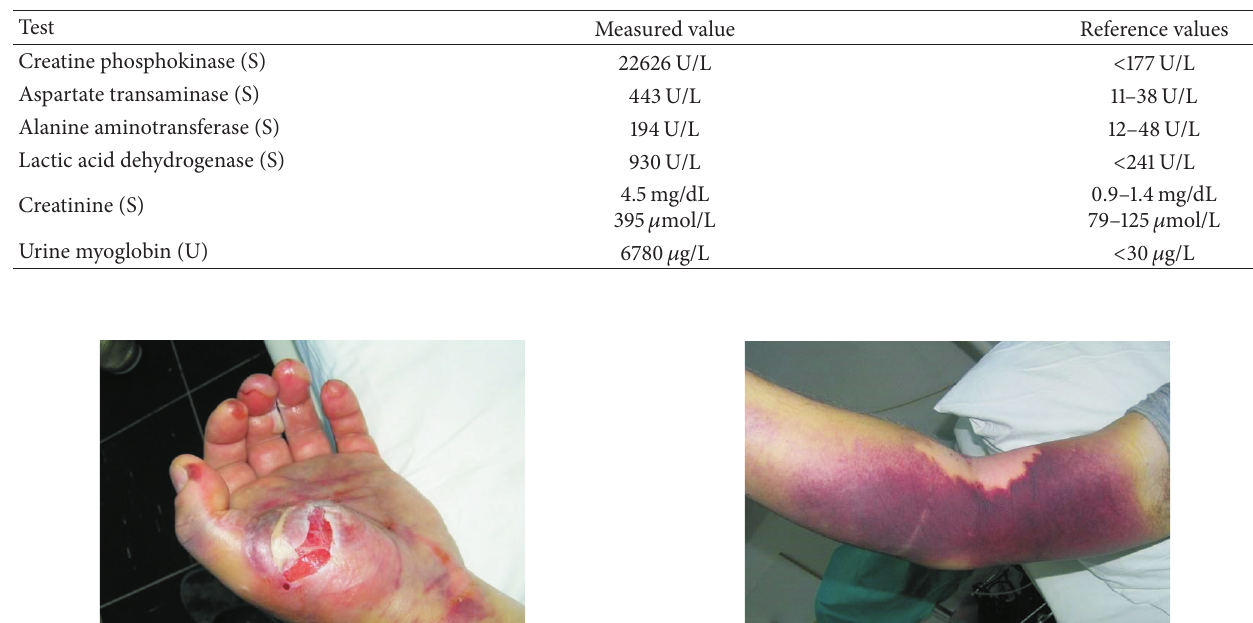
Table 1: The review of abnormal test results in serum (S) and urine (U).